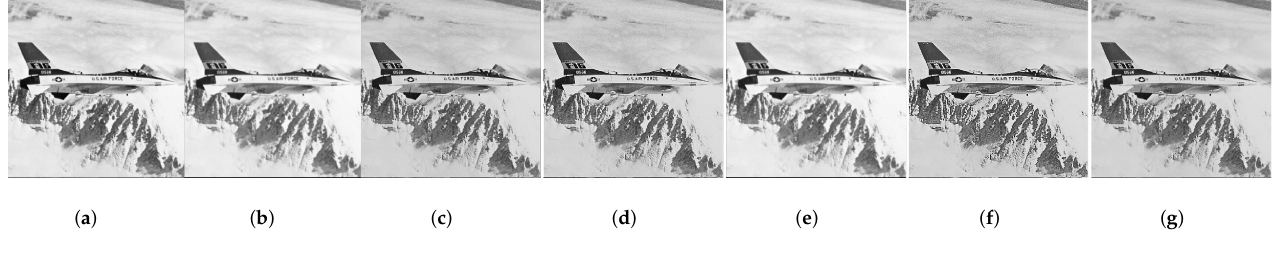
Figure 8. The renderings of plane image under different algorithms. ( a ) Original image. ( b ) 1-order.